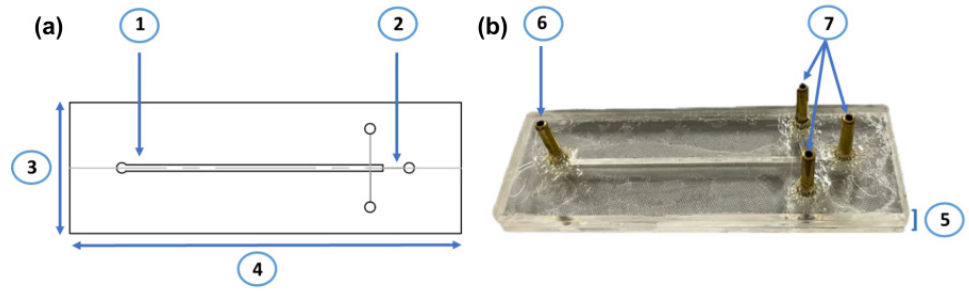
Figure 1. Microreactor design. ( a ) Blueprint of the microreactor, ① main microchannel, ② outlet microchannels, ③ Width of 2.5 cm and ④ Length of 7.5 mm. ( b ) Photograph of a microreactor, ⑤ thickness of 6 mm, ⑥ inlet connector and ⑦ outlet connectors.